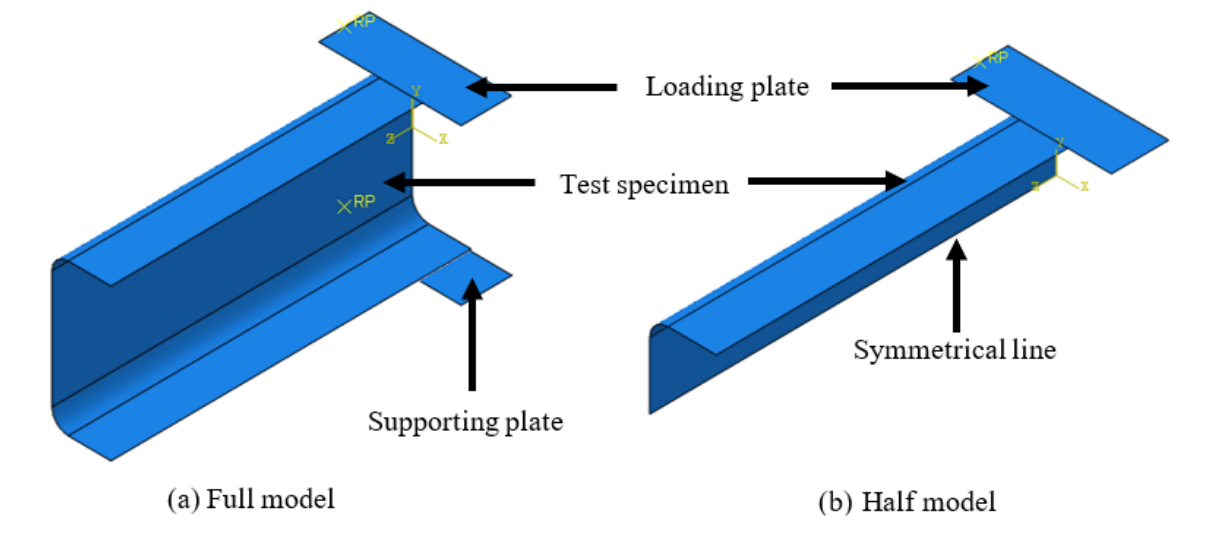
Figure 3. Finite Element model for full and half models.